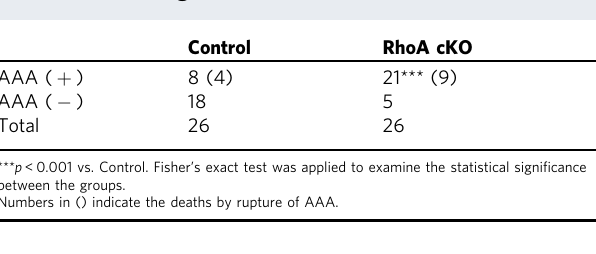
Table 1 Number of mice with or without AAA after treatment with AngII and BAPN.